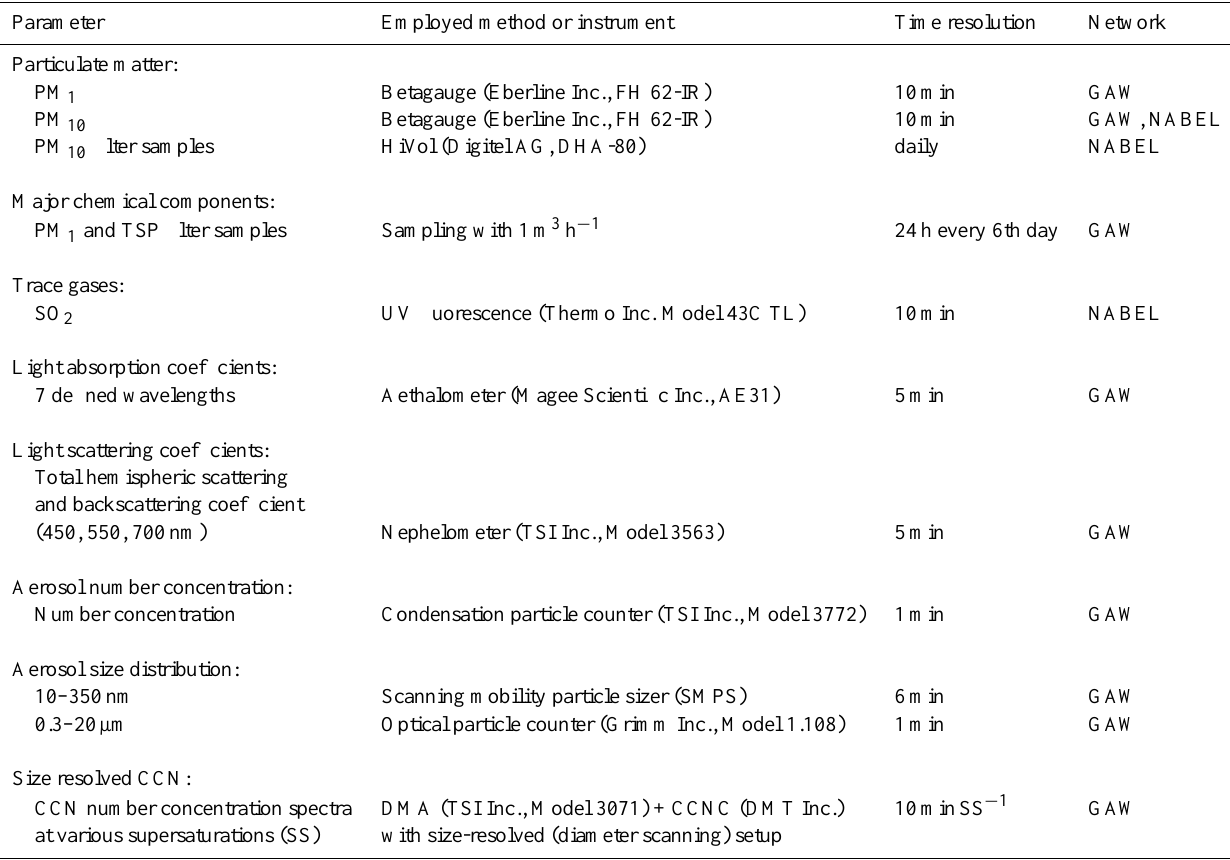
Table 1. Aerosol and gas phase variables relevant for the detection of volcanic aerosol, measured at the High Alpine Research Station Jungfraujoch, Switzerland (3580ma . s . l . ) within the Global Atmosphere Watch program (GAW) run by the World Meteorological Organiza- tion (WMO) and within the Swiss air pollution monitoring network (NABEL). PM 1 , PM 10 : particulate matter with an aerodynamic diameter smaller than 1 and 10µm, respectively. TSP: total suspended particles. CCN: cloud condensation